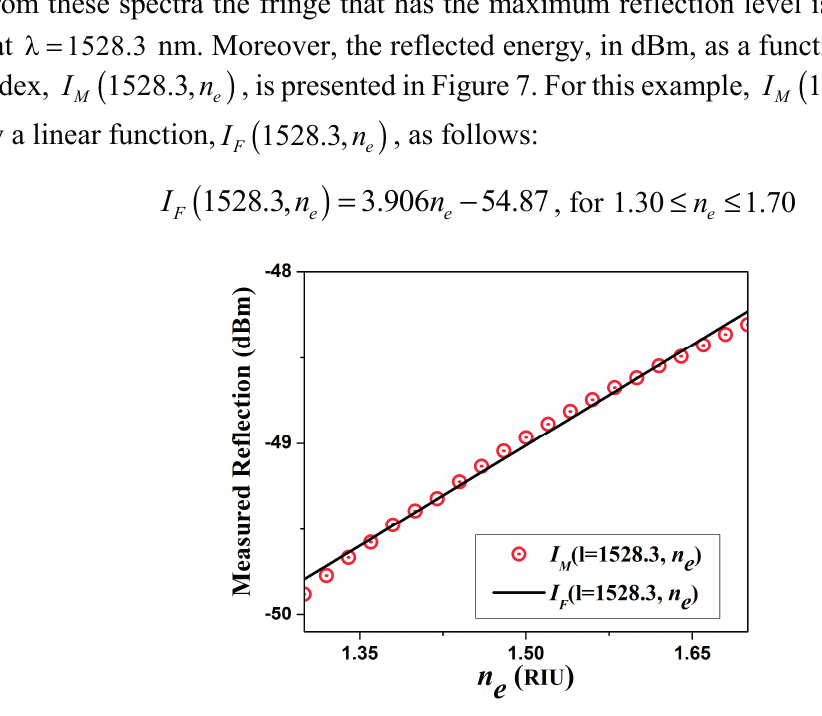
Figure 6. ( a ) Measured reflected power spectra medium refractive index; ( b ) detail of the FPI fringe.